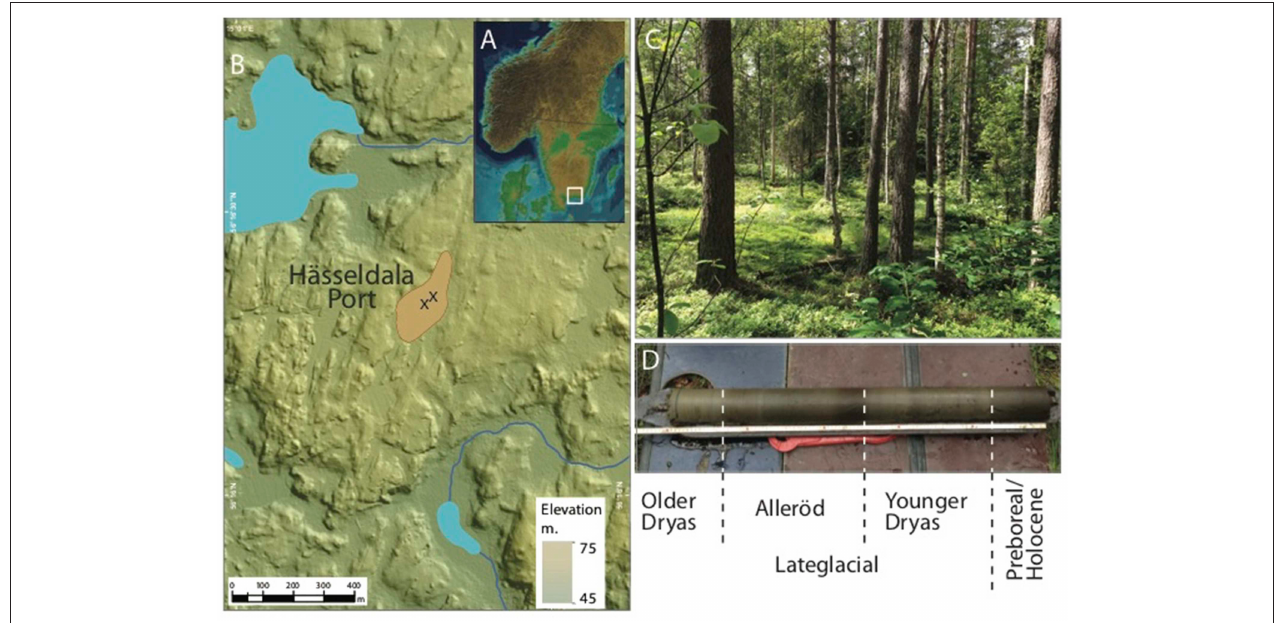
FIGURE 1 | (A) Location of Hässeldala Port in southernmost Sweden. (B) Close-up of the topography around Hässeldala Port. X marks the coring locations; blue = lakes; brown = peatbogs. (C) View over the peatbog at Hässeldala Port. (D) Hässeldala Port’s typical Lateglacial/early Holocene sediment record showing the sediments assigned to the Older Dryas ( > 14.1 ka BP), Allerød (14.1–12.7 ka BP), Younger Dryas (12.7–11.7 ka BP), and Preboreal ( < 11.7 ka BP) regional pollen